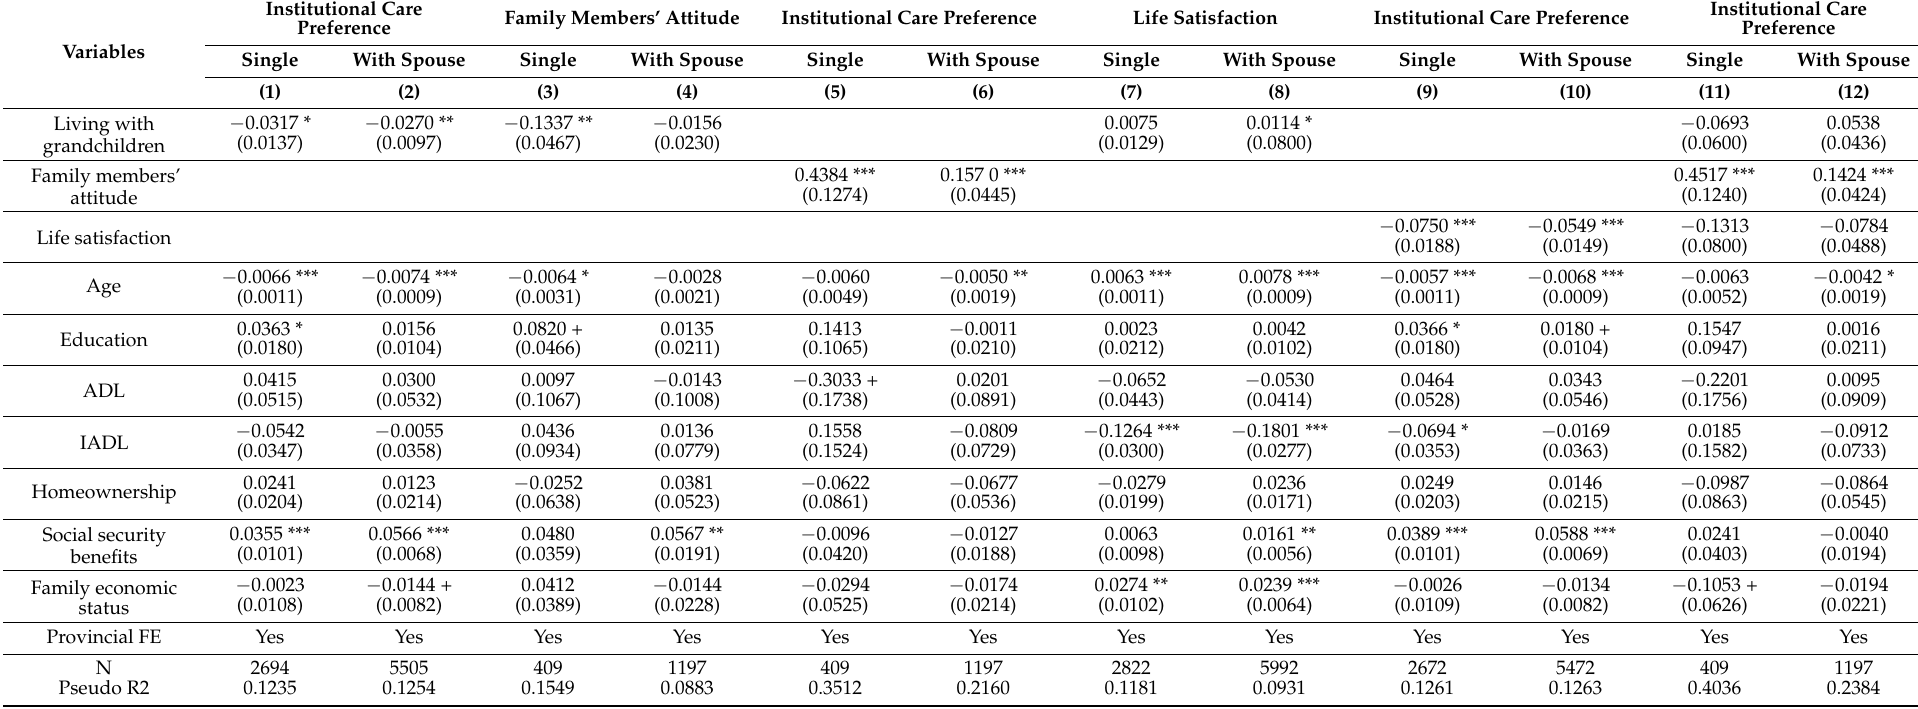
Table 3. Marginal effect on heterogeneous effects of single older people: determinants of institutional care